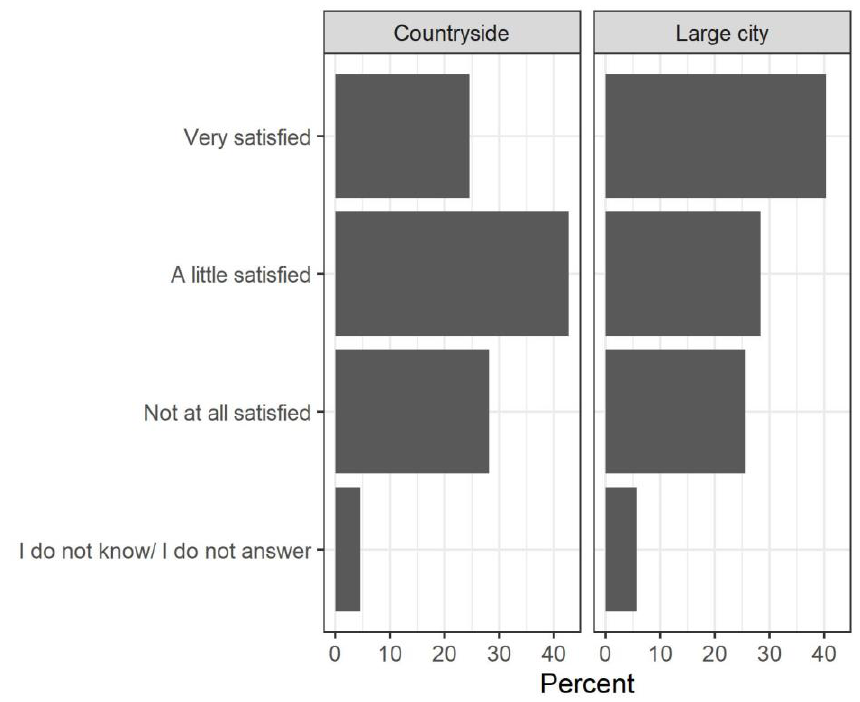
Figure A7. Cross-tabulation of attitudes of believers about the reaction of the Church by city (% by city). Χ 2 = 10.4732, df = 3, p = 0.015.